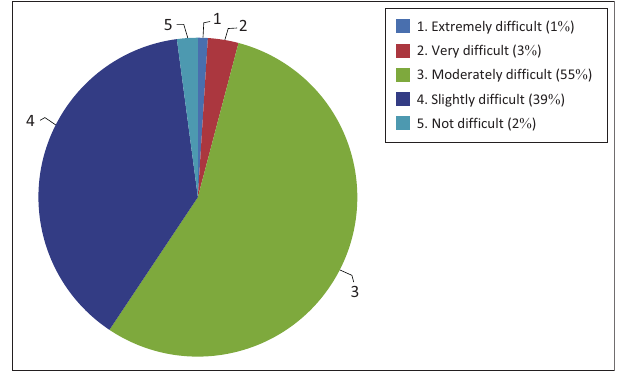
FIGURE 2: Level of difficulty in hearing a person speaking through a mask or shield ( n =